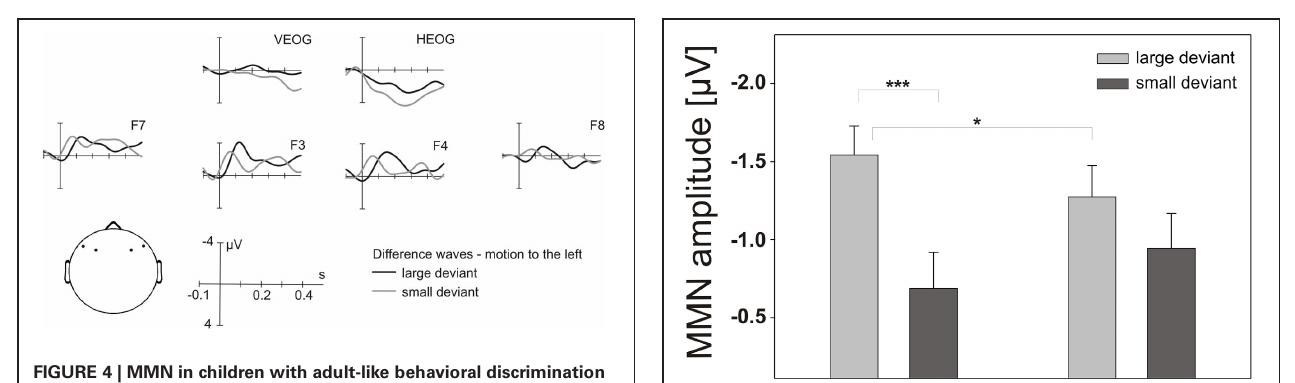
FIGURE 4 | MMN in children with adult-like behavioral discrimination performance. Simulated motion to the left, difference waves of ERP (Deviant-Standard) for the large deviant (black line) and the small deviant (gray line) at selected electrodes: F7, F3, F4, and F8. Vertical and horizontal eye electrodes: VEOG and HEOG.